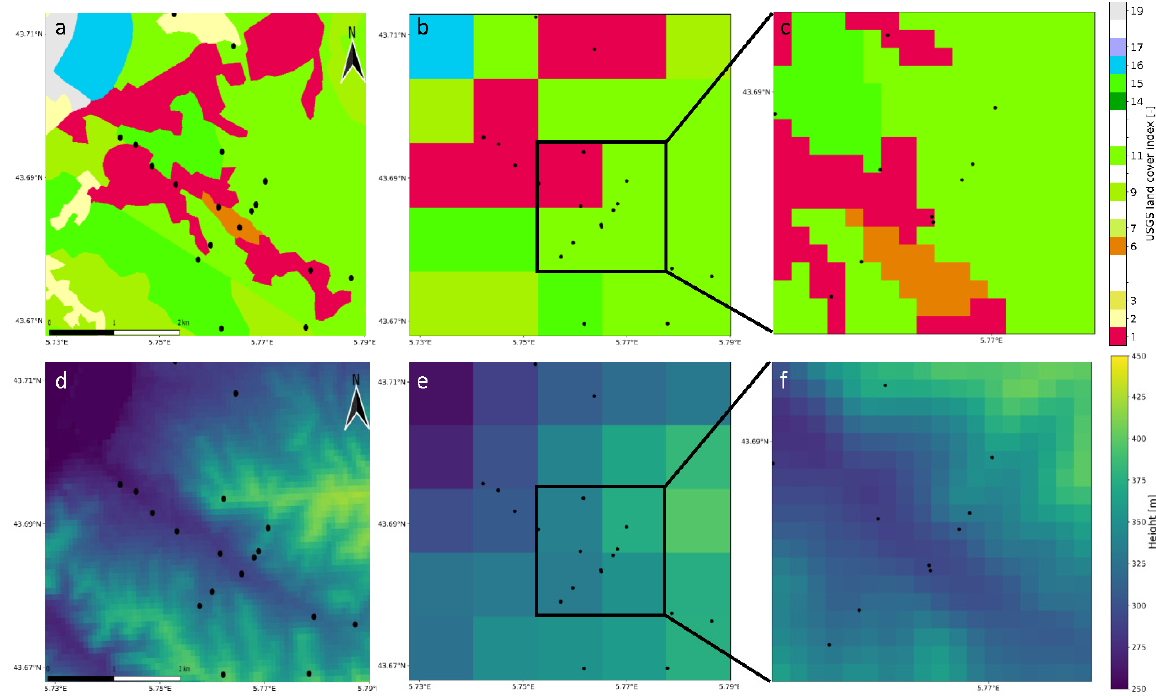
Figure 5. Representation of the surface characteristics (land use on the top and topography on the bottom) according to the horizontal resolution. In ( a , d ), the finest available resolution is presented on an area of 5 × 5 km encompassing the Cadarache valley. In ( b , e ), the description is degraded to a single value for each 1 × 1 km cell, whereas in ( c , f ), a sub-area is zoomed in on with the corresponding values for the 111 m horizontal resolution. The locations of the stations (black dots) sometimes fall in a single cell for the 1 km resolution (their names are provided in Figure 2), whereas at the finest resolution, all the stations lie in different cells. Appendix B contains a table with the color coding of the land use